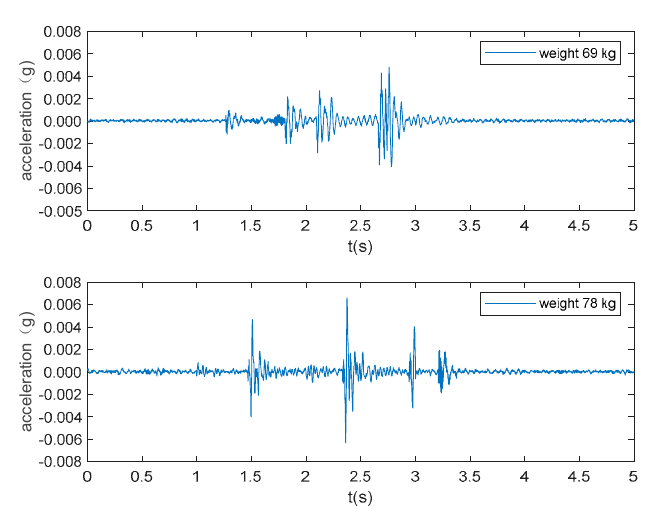
Figure 8. Volunteers (78 kg and 69 kg) walking.